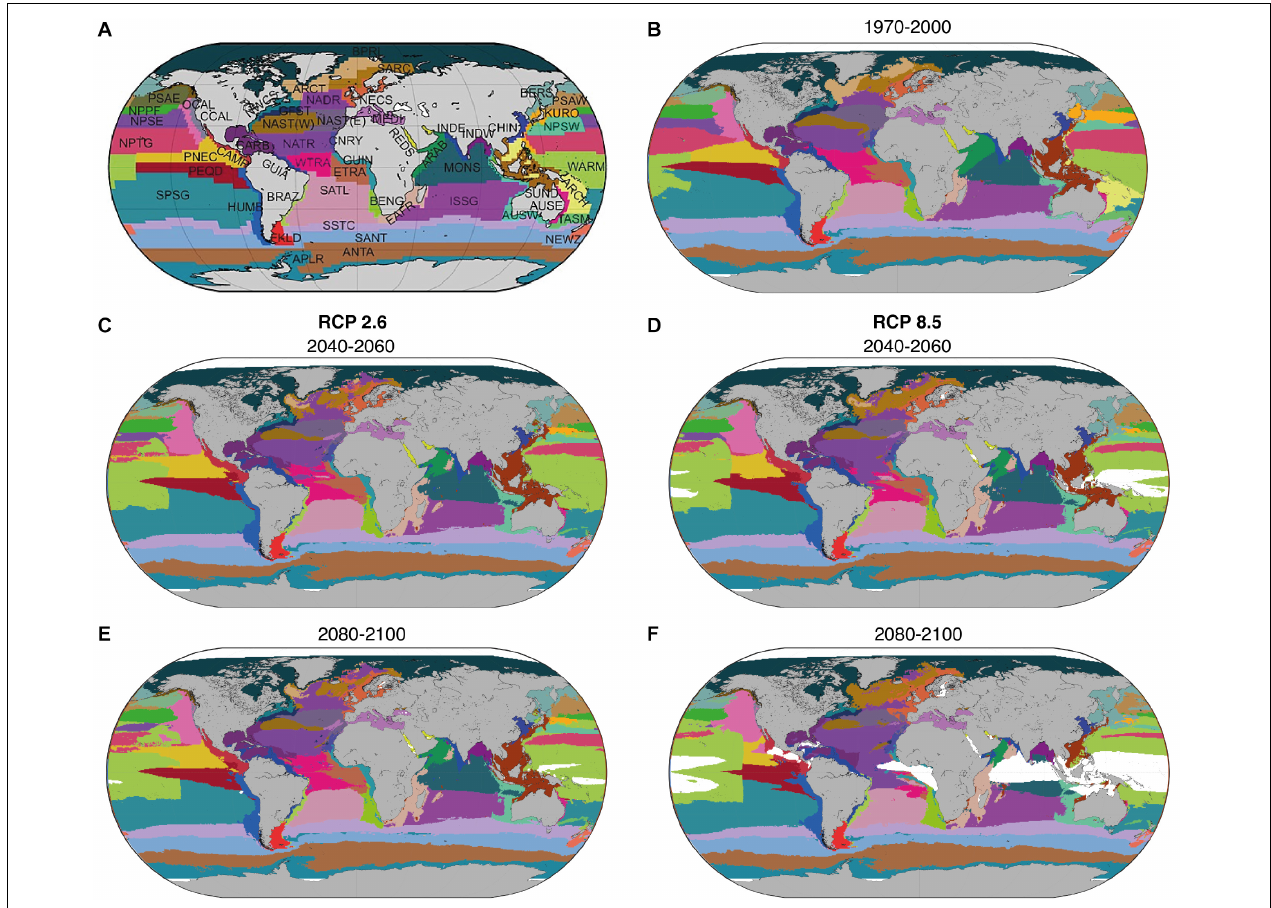
FIGURE 1 | Distribution of the 56 BGCPs: (A) according to Longhurst (2007); and for (B) the average period 1970–2000, (C,D) for 2040–2060, and (E,F) 2080–2100 under representative concentration pathway 2.6 and 8.5, respectively. Distributions of each province were averaged across the three Earth System Models and three Environmental Niche Models. Each color represents a BGCP. Color coding refers to panel (A). Acronyms of each BGCP can be found in Supplementary Table 1